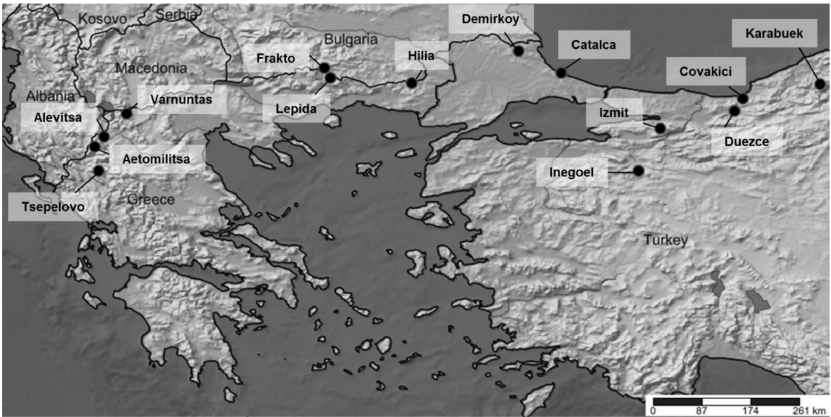
Figure 1. Locations of the sampled populations in Greece and Turkey. The German reference populations are not shown. The map was generated with SimpleMappr